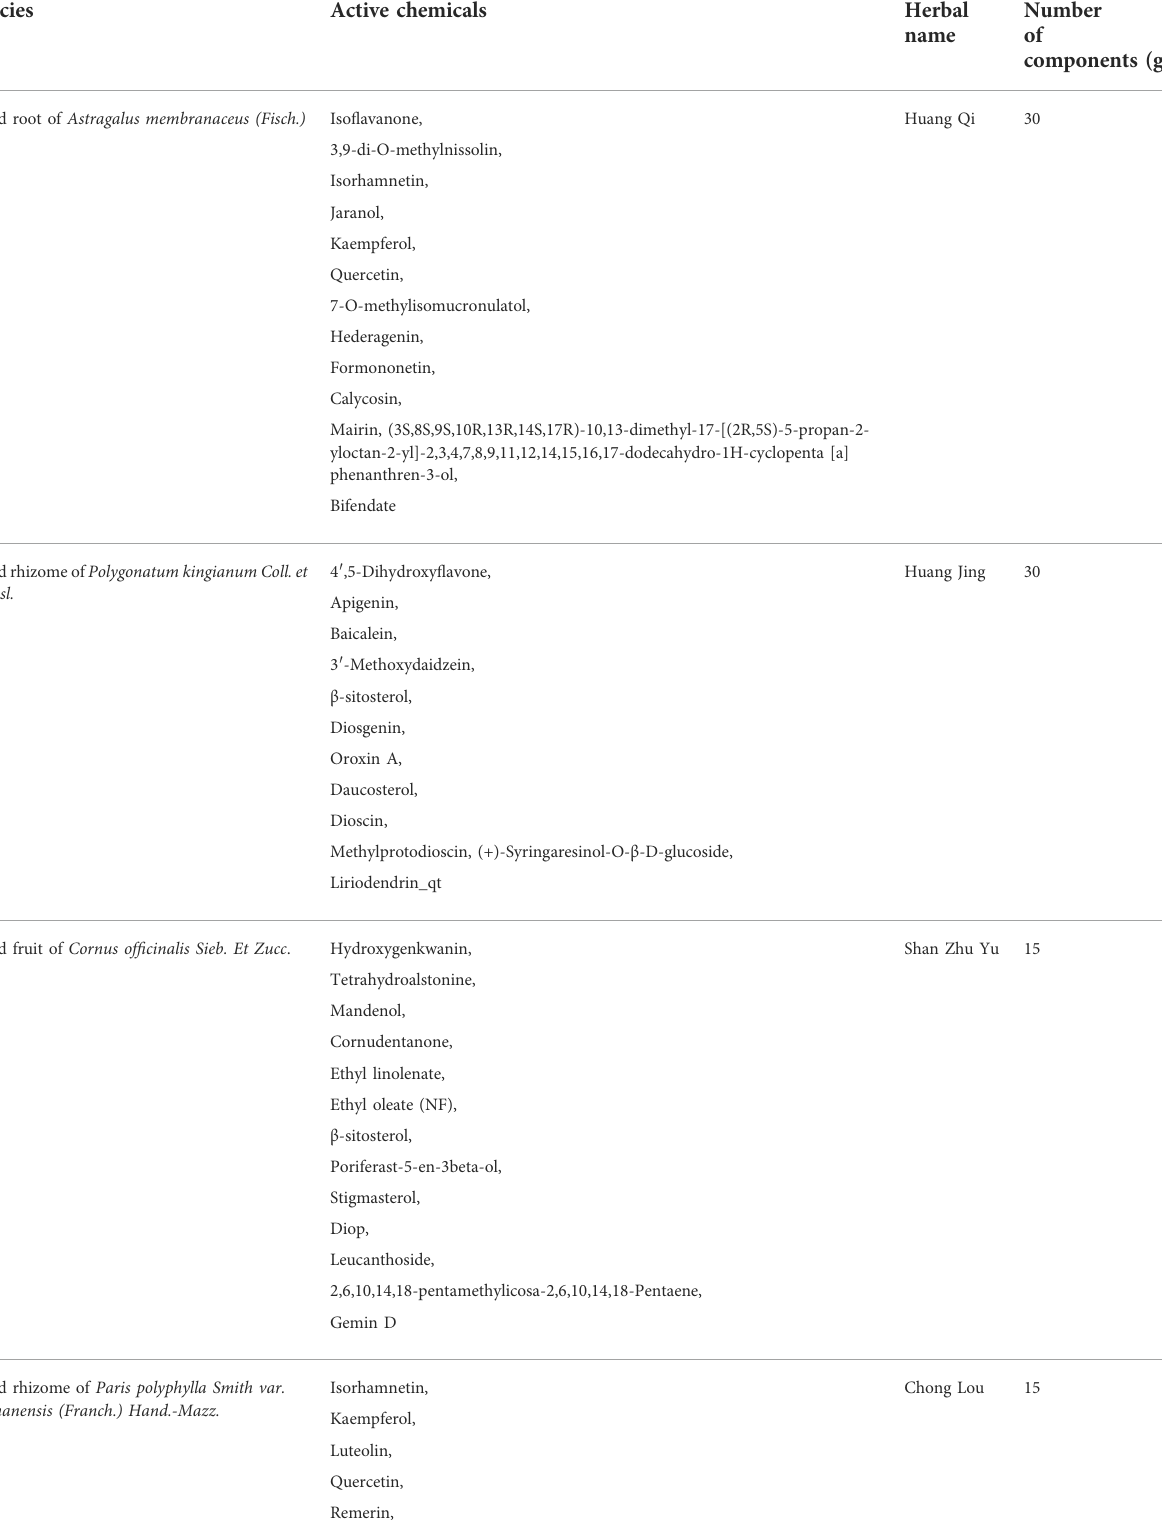
TABLE 1 FYN components.